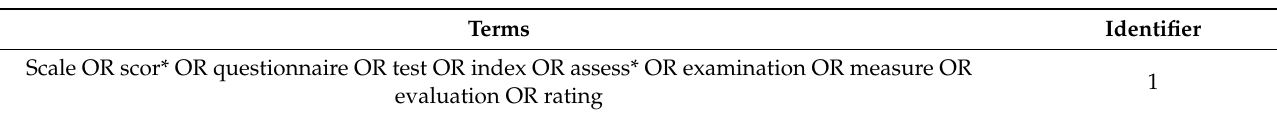
Table 1. Terms and search